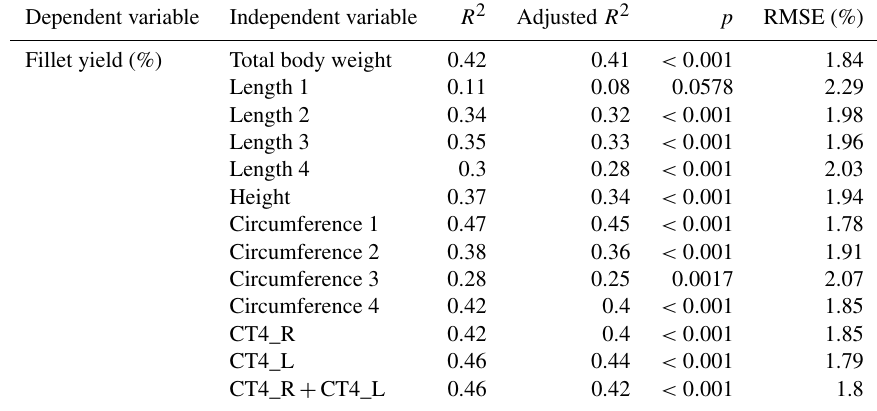
Table 7. Results of single linear regression between fillet yield (%), linear measurement and CT measurement; n =